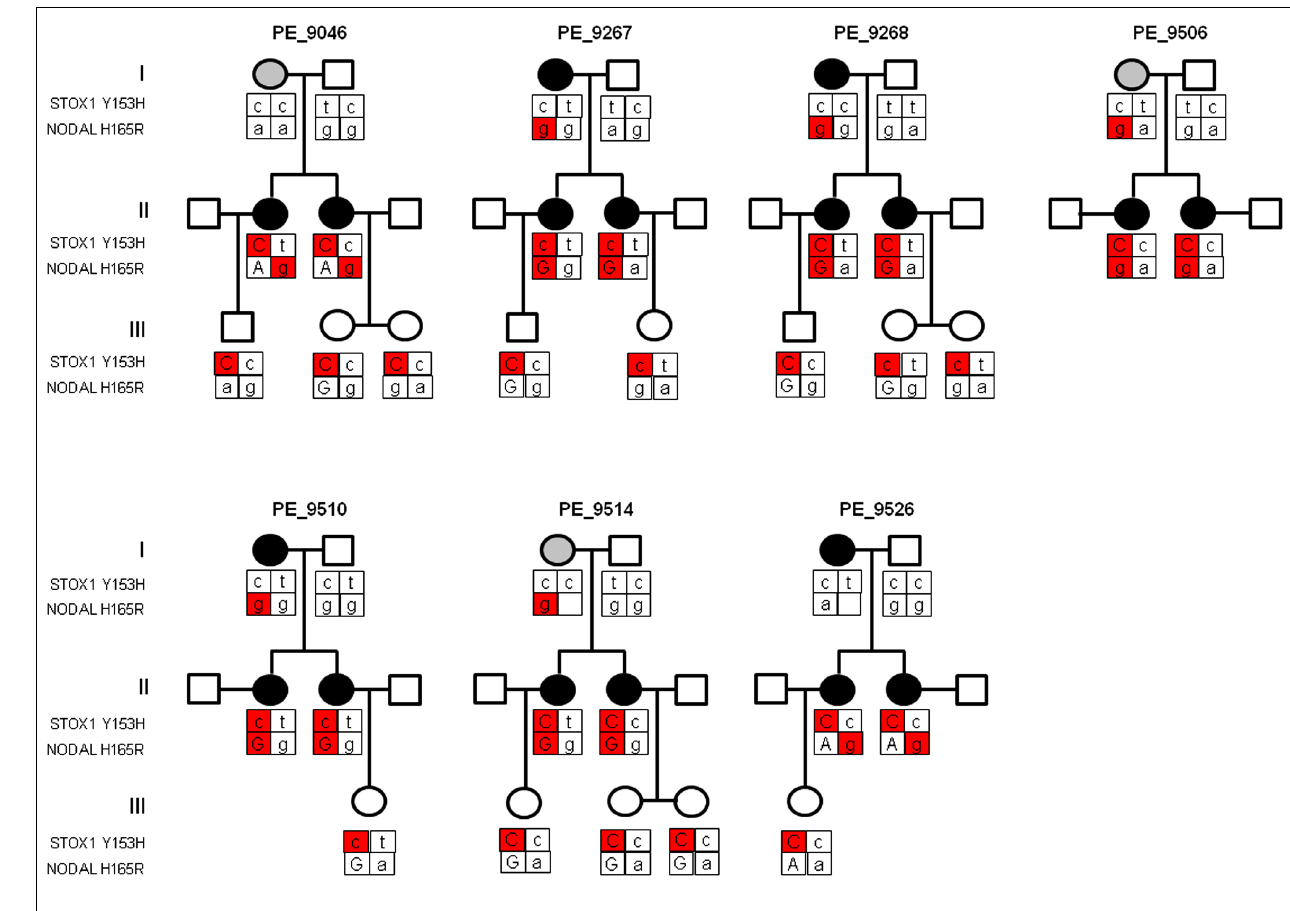
to the pre-eclampsia phenotype, at placental and maternal level respectively, are indicated in red. As the pre-eclampsia linkage in this locus showed matrilineal transmission, only the STOX1Y153H SNP with maternal origin is marked in red. Individuals born from complicated pregnancies (generation II and III) all carry the STOX1Y153H SNP. Mothers who suffered from a complicated pregnancy (generation I and II) all carried the NODAL H165R SNP originating from the mother (marked in red), except in families PE_9046 and PE_9526 where the SNP in generation II originates from the